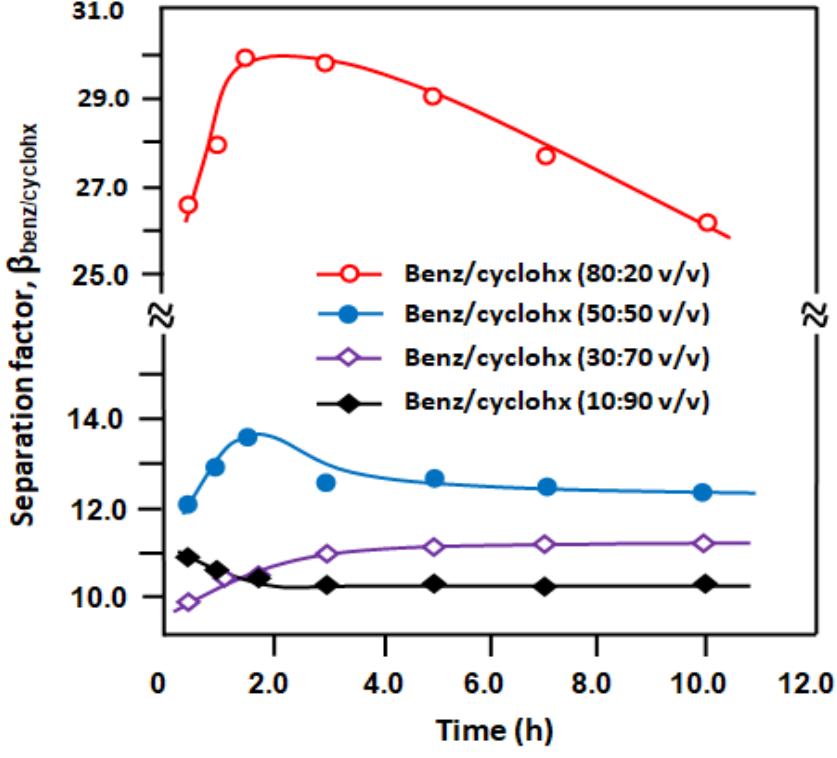
Figure 10. Change in the separation factor of benzene/cyclohexane mixtures with different compositions versus time using the E-VOH-membrane.